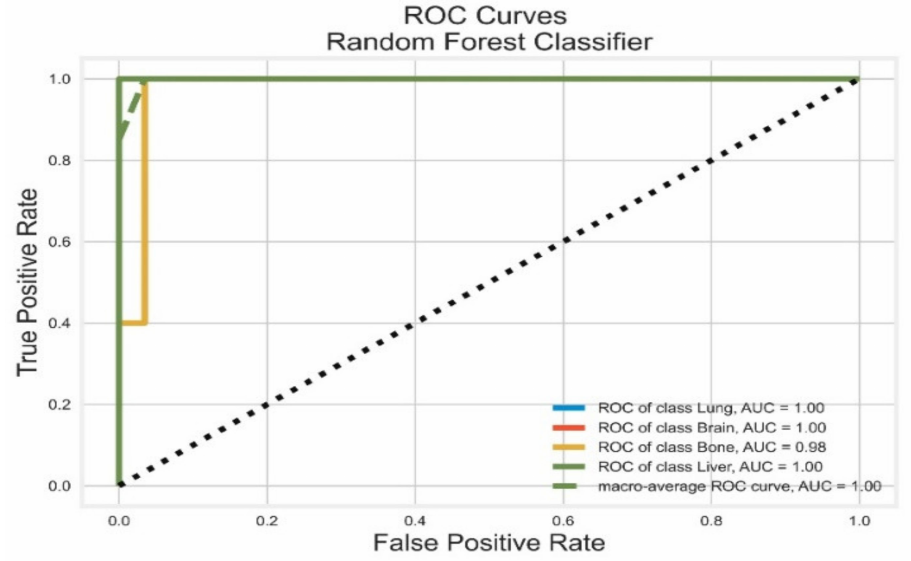
Figure 20. ROC Curves (Random Forest